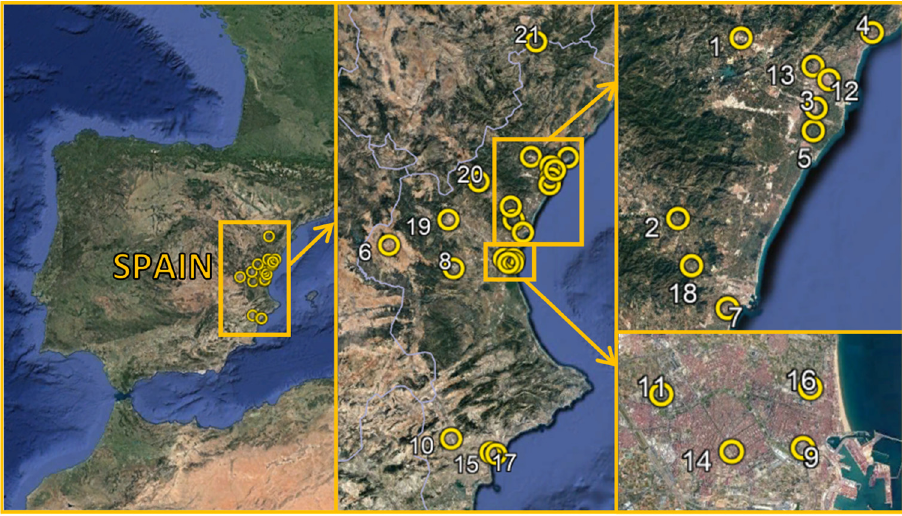
Figure 1. Location of the monitoring air quality stations on the Spanish Mediterranean coast. Map data: © 2022 Google. Image Landsat/Copernicus.